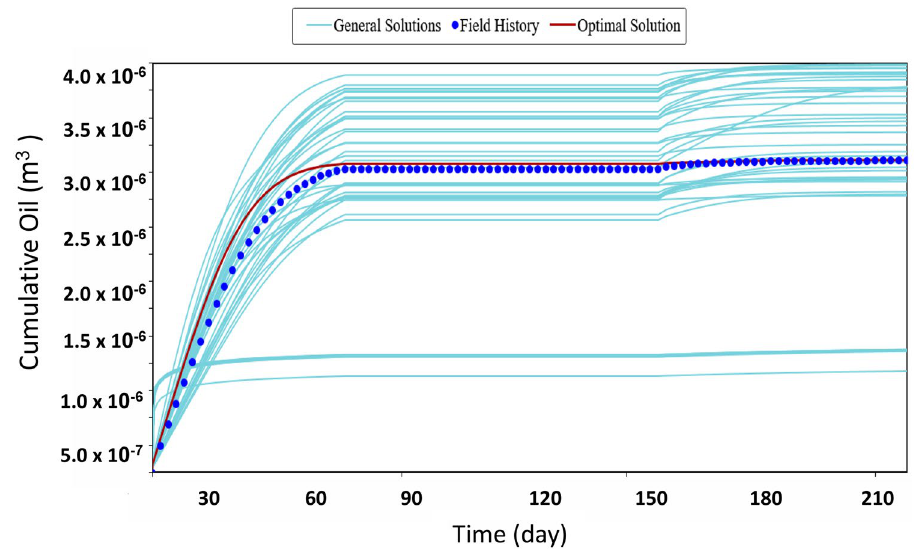
Fig. 5 Oil recovery—history match against experimental data (blue